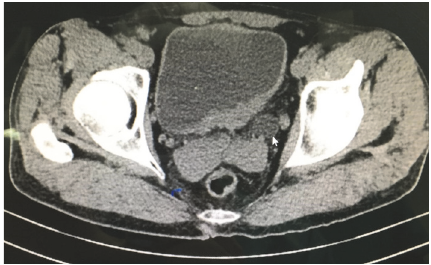
Figure 3: Mass on the left wall of bladder and ureter dilatation. The arrow shows the dilatation of ureter.